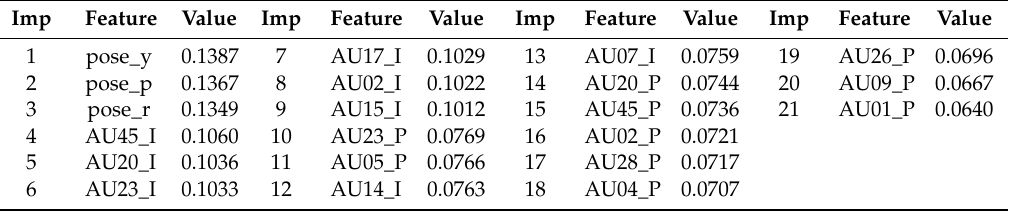
Table 5. Features importance for the FF4 by using RFc (5k), I – intensity, P – presence. The features in table are ordered by their importance from most important to least